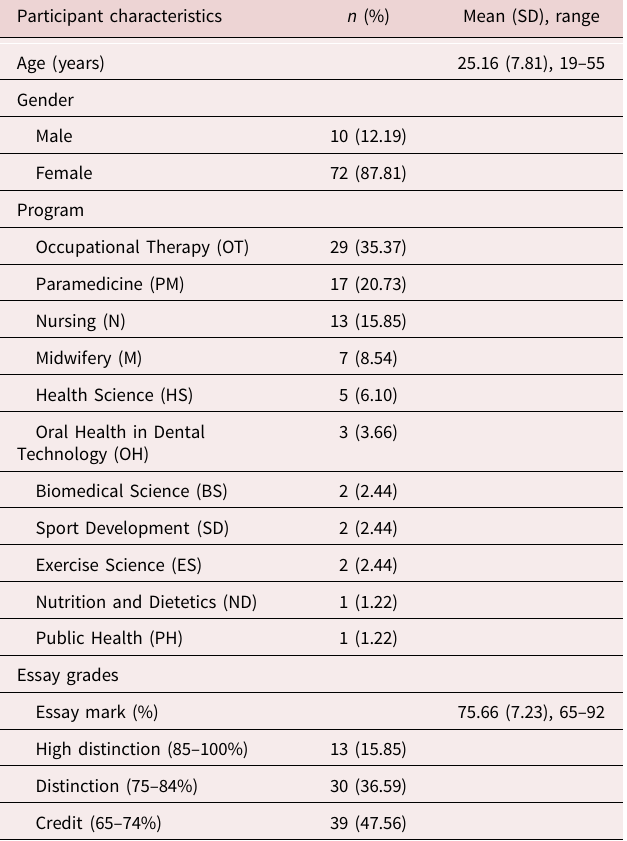
Table 1. Participant characteristics Participant